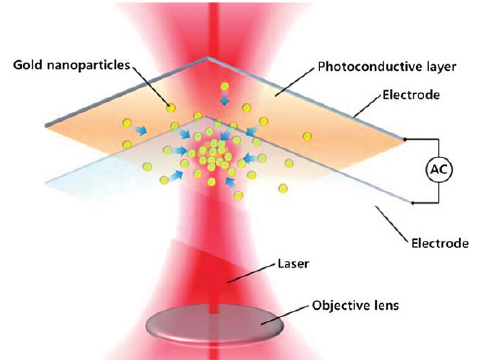
Figure 8. Schematic of the OET-based SERS sensing system, allowing on-demand generation of SERS-active sites and in situ measurement of the enhanced SERS signal (Reproduced with permission from